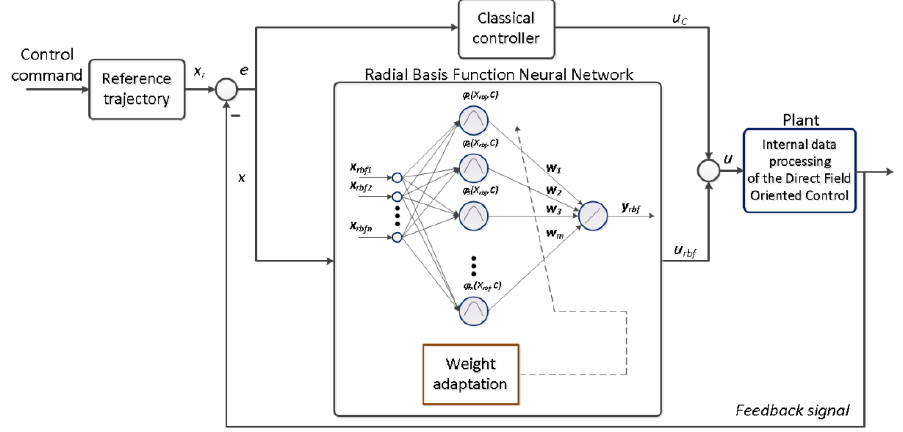
Figure 2. The scheme of adaptive control structure.